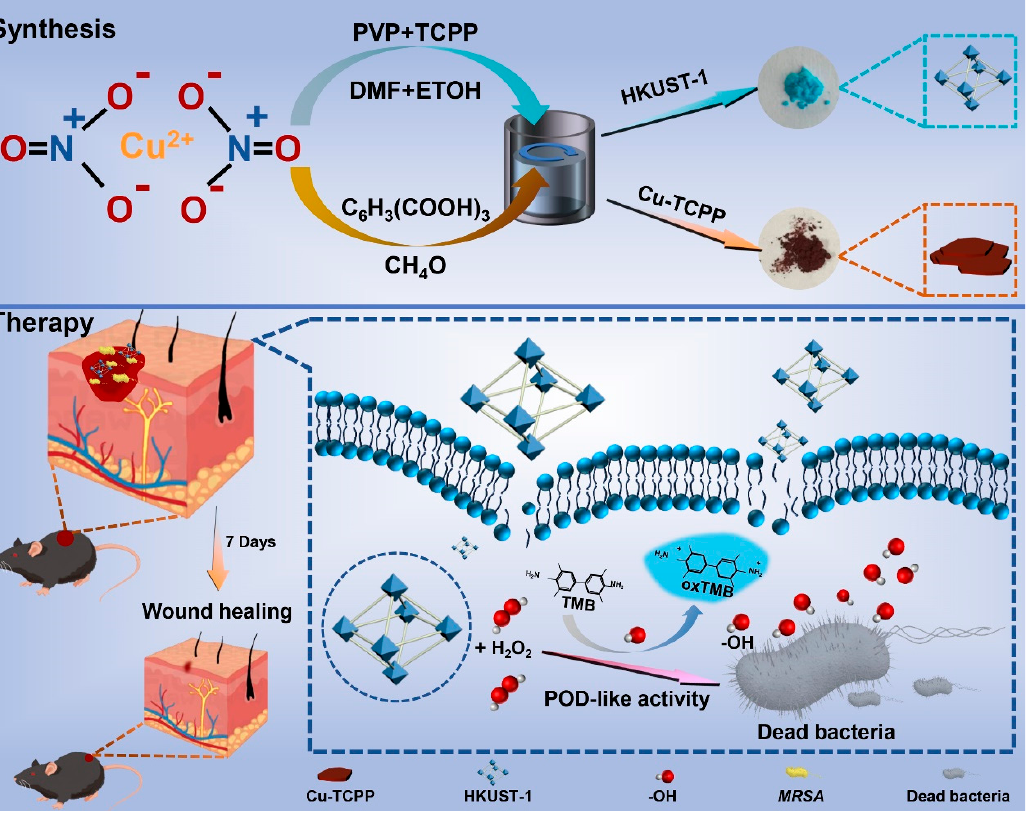
Scheme 1. Schematic illustration of the preparation of two different dimensional Cu-MOFs with POD-like activity for antibacterial and wound healing. POD-like activity for antibacterial and wound